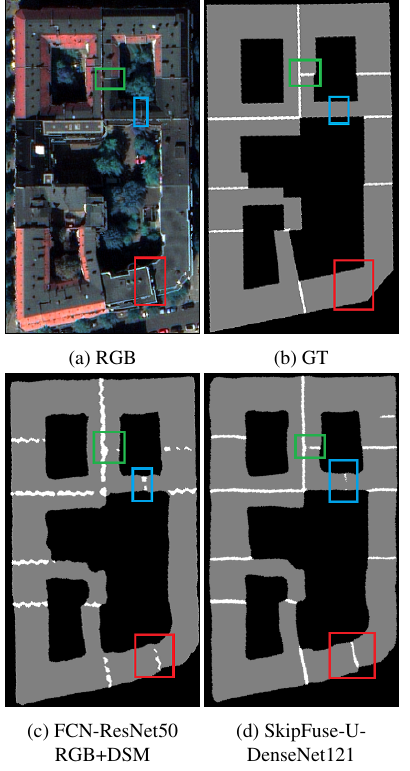
Figure 6. Comparison of the segmentation results of the (c) FCN-ResNet50 trained on RGB and DSM and (d) the SkipFuse-U-DenseNet121 with the (a) RGB and (b) the ground